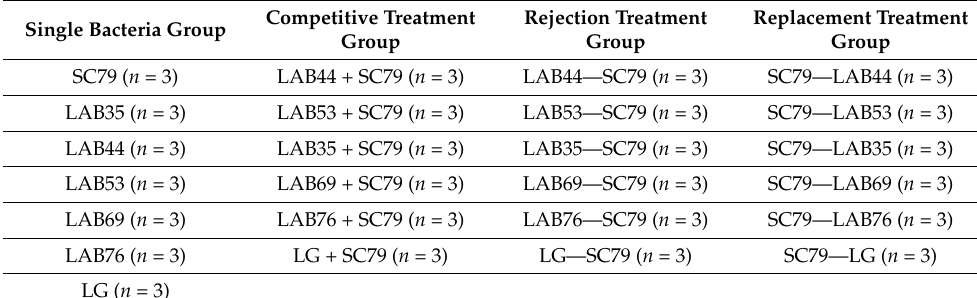
Table 2. Treatment of Caco-2 cells with different combinations of